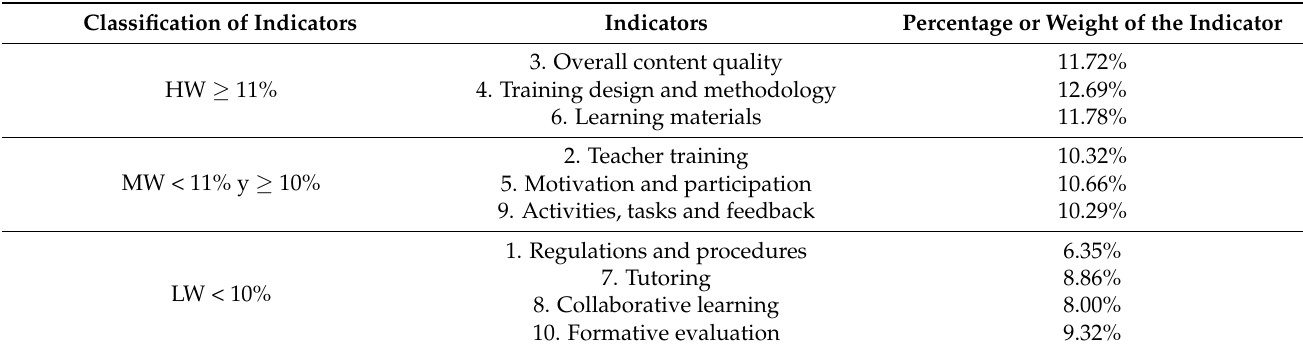
Table 5. Classification of the indicators of the instrument according to their in post-compulsory education and with synchronous modality (scenario 6).